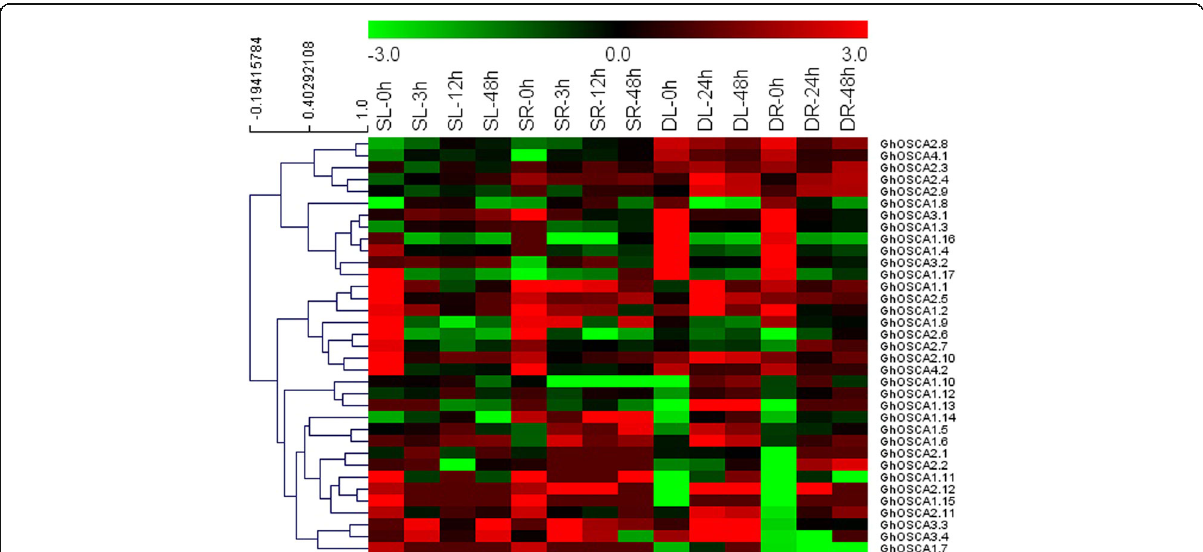
Fig. 6 Expression analysis of GhOSCA genes in G. hirsutum under salt and drought stresses. The RNA-Seq expression profiles of G. hirsutum were used to identify the relative expression levels of GhOSCA genes. Levels of gene expression are depicted in different colors on the scale. Red color represents high expression and green color represents low expression